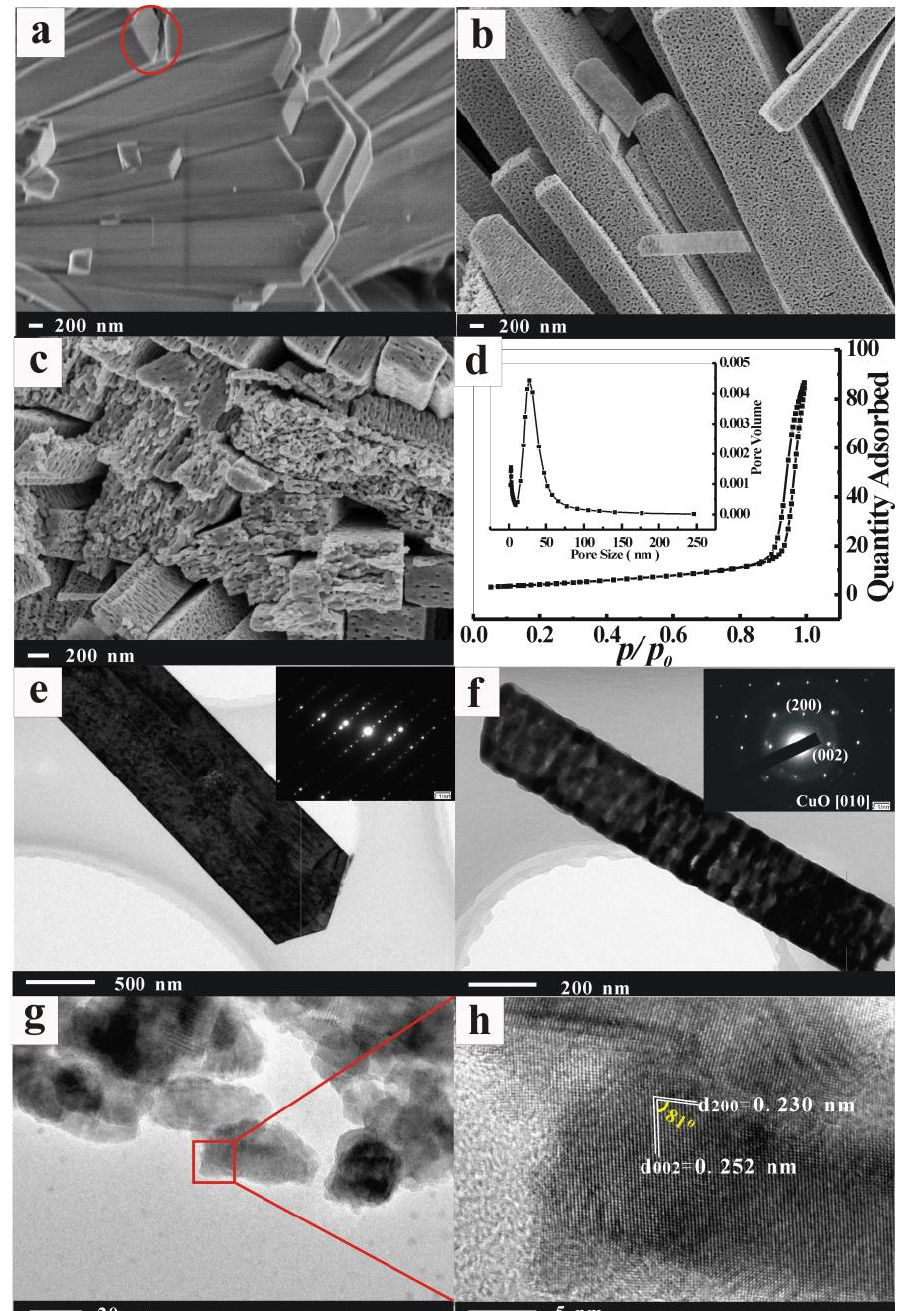
Figure 2. FESEM images of ( a ) Cu 2 (NO 3 )(OH) 3 and ( b , c ) CuO. ( d ) The N 2 adsorption – desorption isotherm together with the BJH pore size distribution plots (inset) of CuO sample. TEM images and SAED patterns (inset) of ( e ) Cu 2 (NO 3 )(OH) 3 and ( f ) CuO. ( g , h ) HR-TEM images of CuO.